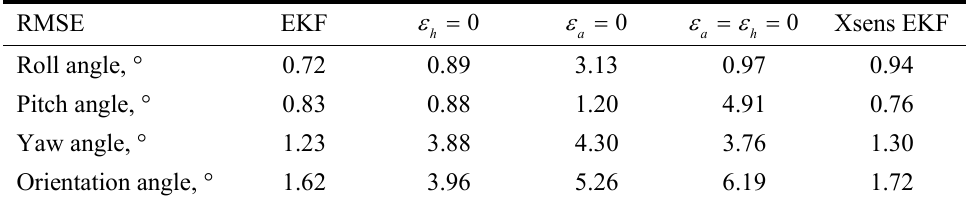
Table 2. Performance